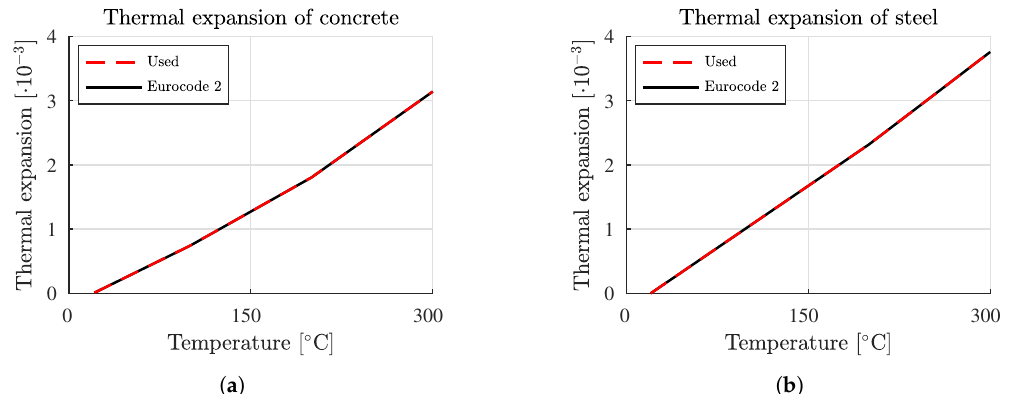
Figure 16. Coefficients of thermal expansion as a function of the temperature, according to Eurocode 2 [43], for: ( a ) concrete and ( b ) steel.